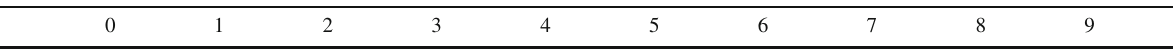
Table 1 The first few mass ratios R nil for the 3D nilmanifold N 3 , corresponding to Eq. (2.32) for κ = 1